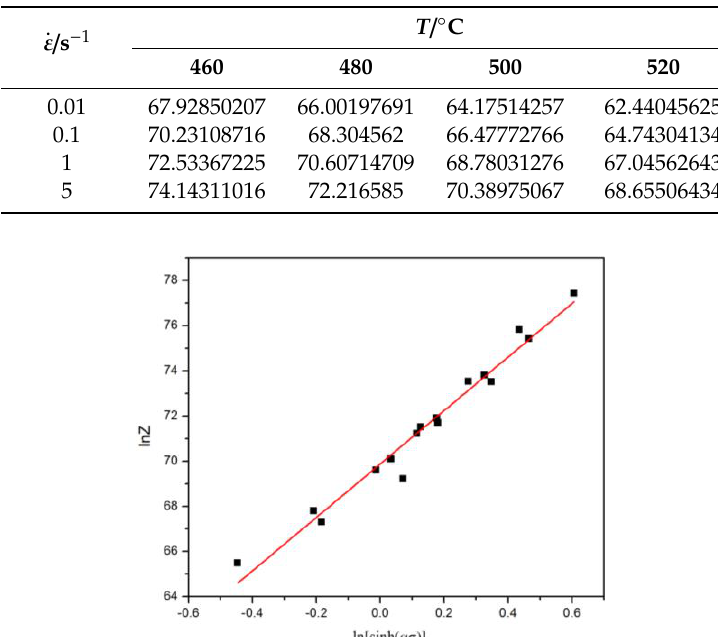
Table 3. The value of ln Z .